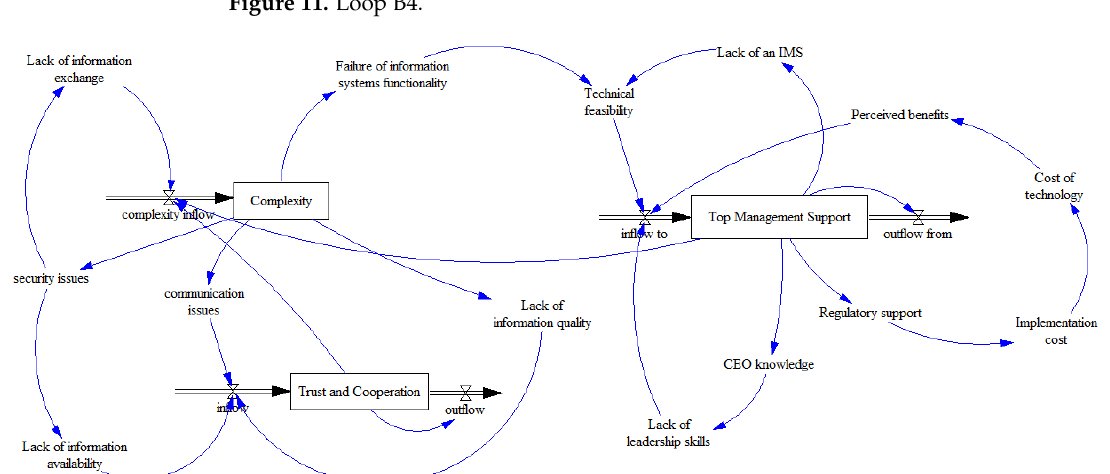
Figure 11. Loop B4.